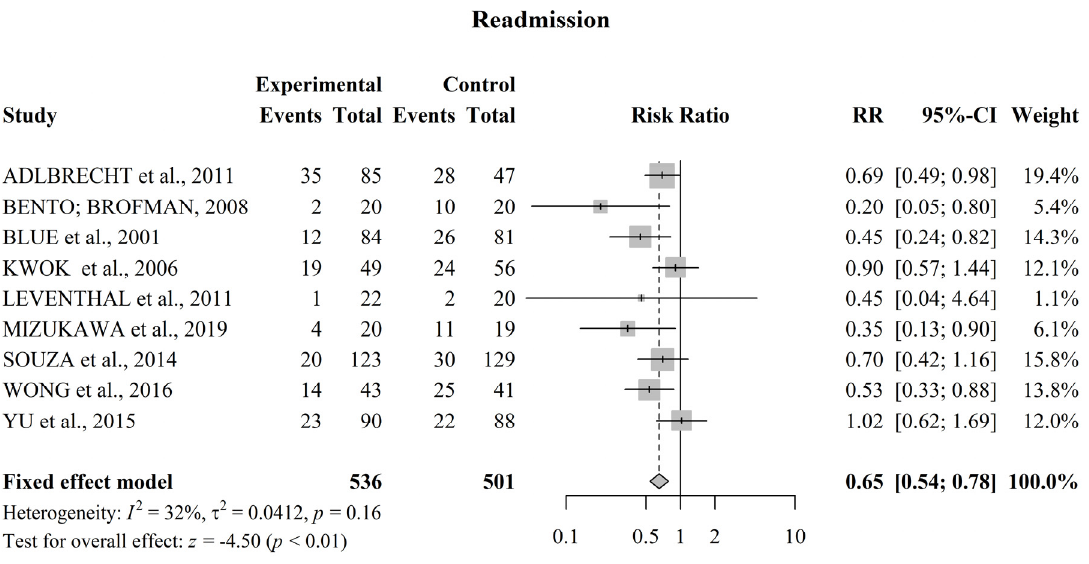
Figure 2. Forest plot of the effect of educational nursing interventions on reducing readmissions in patients with HF. The meta-analysis identified a 36% reduction in the risk of readmission [RR 0.64, 95% CI, 0.54 − 0.75, p < 0.01]. CI = confidence interval; RR = relative risk. References involved in the study: [12–17,20–22].